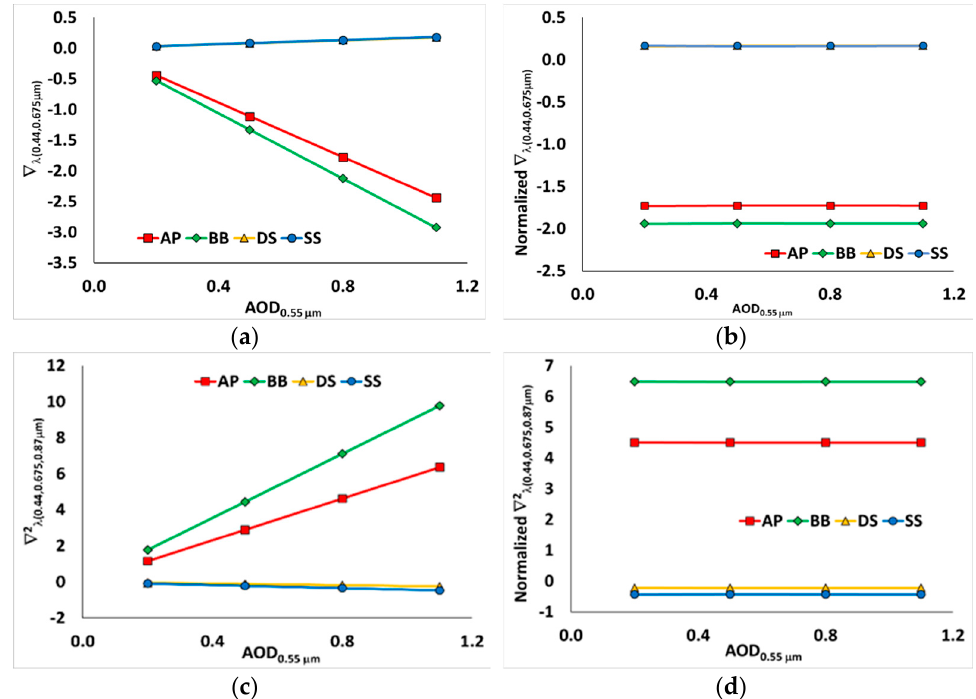
Figure 3. The comparison of first-order derivatives with respect to aerosol loadings (AOD 0.55µm ) before ( a ) and after normalization with AOD 0.44µm ( b ) and the comparison of the second-order derivative wavelengths before ( c ) and after normalization with AOD 0.44µm ( d ).